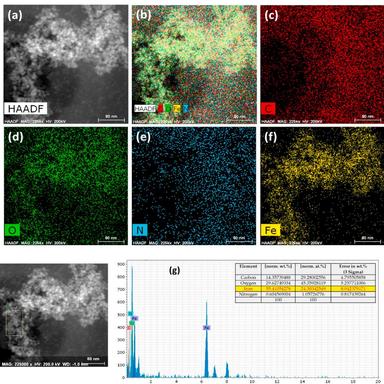
(a-b) HAADF-STEM image of the LBG-cl-PAN- IONP HNC; and the corresponding elemental mapping for (c) carbon, (d) oxygen, (e) nitrogen and (f) iron contents.